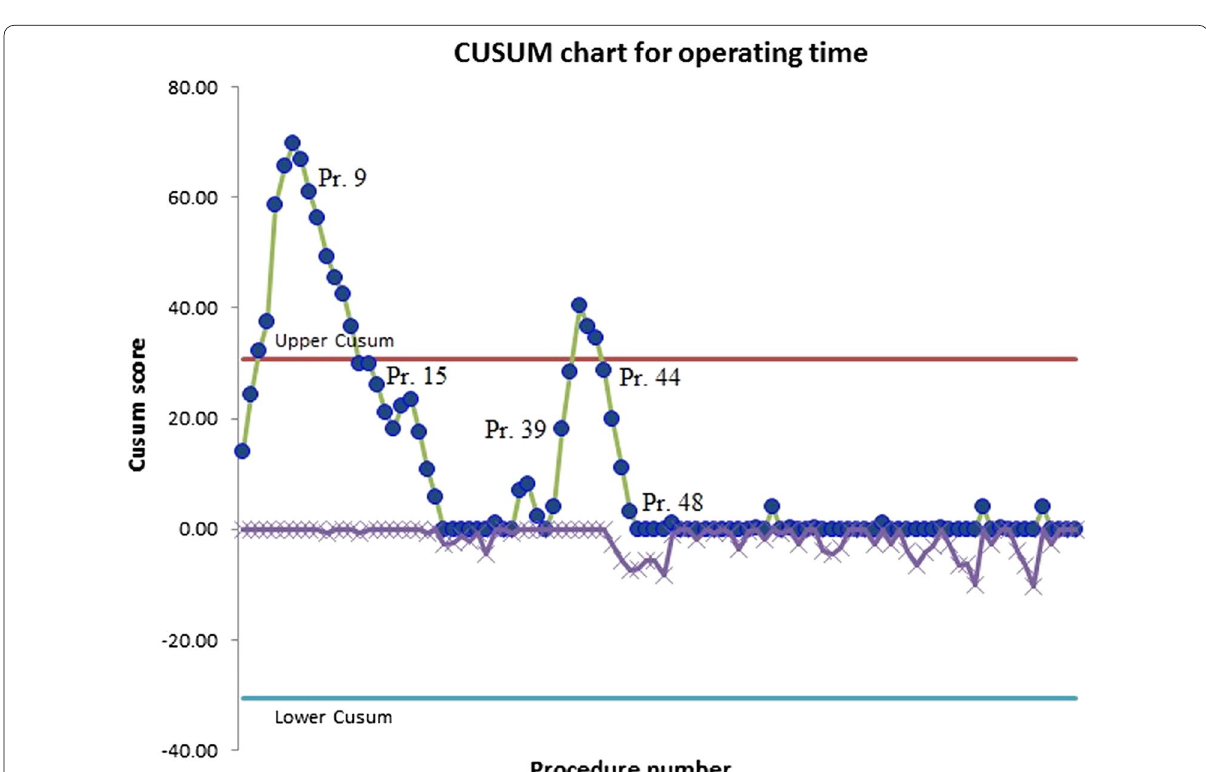
Fig. 3 CUSUM analysis of operating time revealed beginning of improvement at the 9th procedure, controlling the duration at the 27th procedure and reaching steady state at the 53rd procedure. Between the 39th and 42nd procedures there was an upward deflection of the curve above the upper CUSUM line (out-of-control process) due to OR team